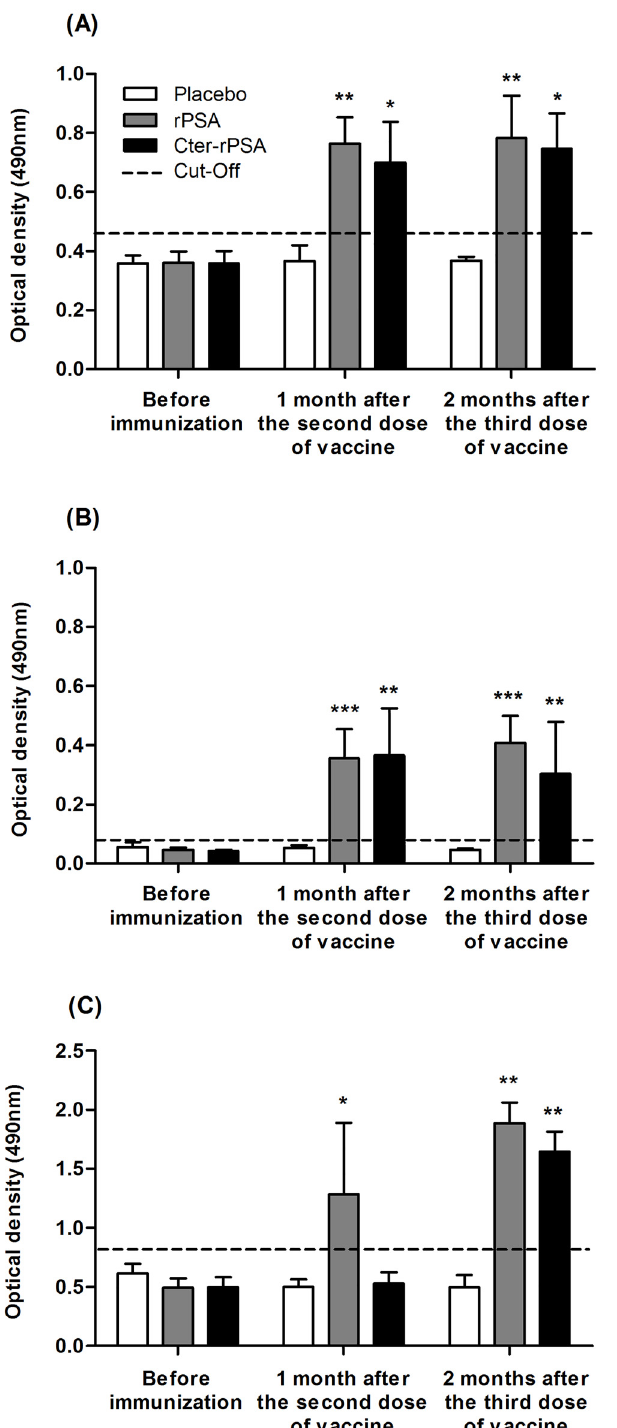
Fig 2. Vaccine specific serological responses as detected by Enzyme-Like Immunosorbent Assay (ELISA). Evolution of levels of (A) anti-rPSA, (B) anti-Cter-rPSA and (C) anti- Li ESAp specific IgG2 antibodies was assessed in serum samples isolated from dogs of each group immediately before immunization and at different times post-immunization: first month after the second dose and two months after the third dose. Each serum sample was tested in triplicates. Cut-off value was calculated using the following formula: mean OD in sera from all dogs before immunization + 3 standard deviations. Values represent means OD +/- standard deviation of triplicate experiments ( * p < 0.05, ** p < 0.01, *** p < 0.001).